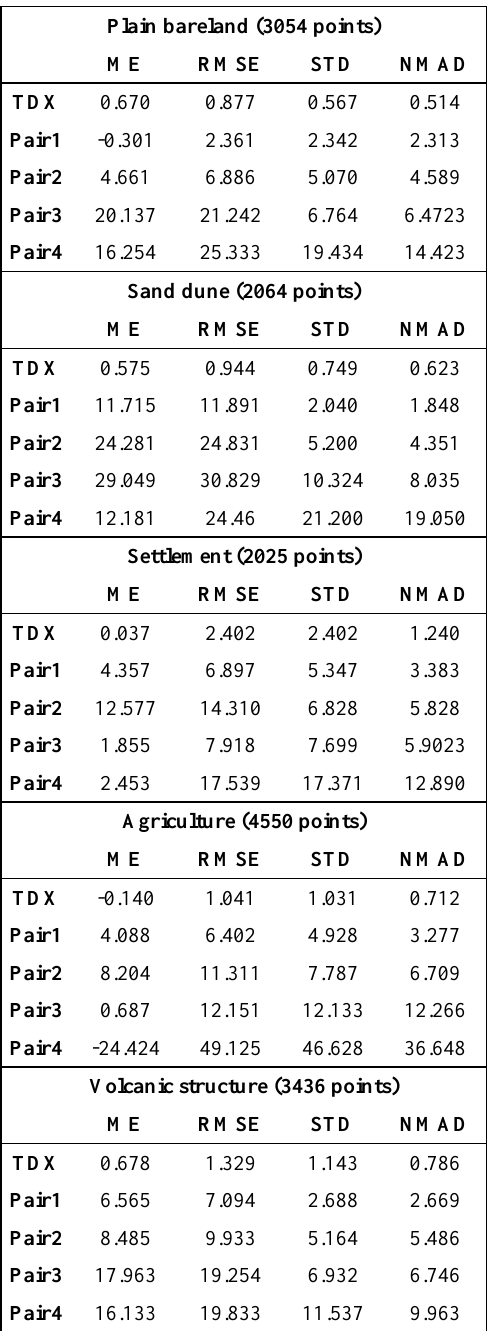
Table 3. Statistical analysis of the results in meter